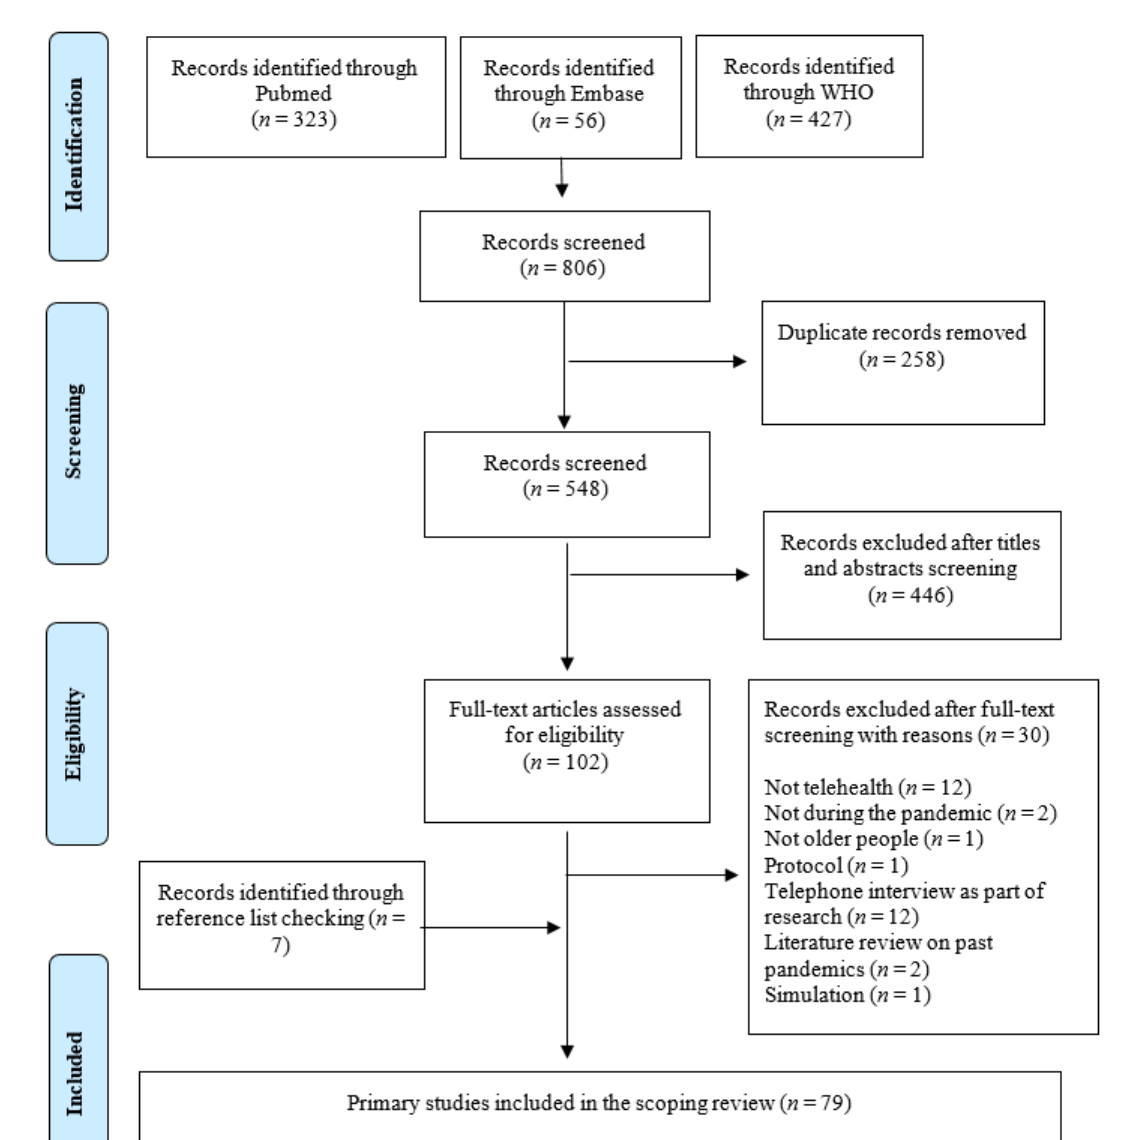
Figure 1. PRISMA 2009 flowchart of the scoping review’s inclusion.